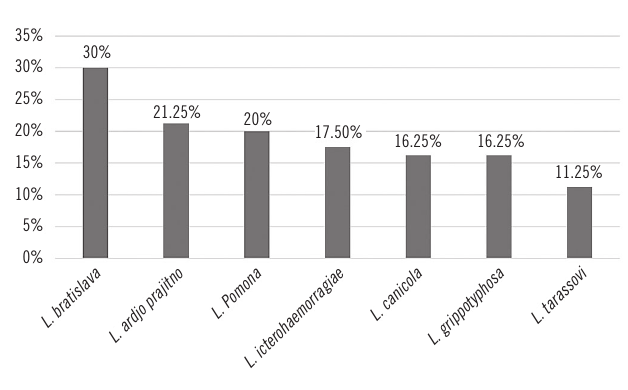
FigurE 2 − Percentage of positivity for Leptospira spp.